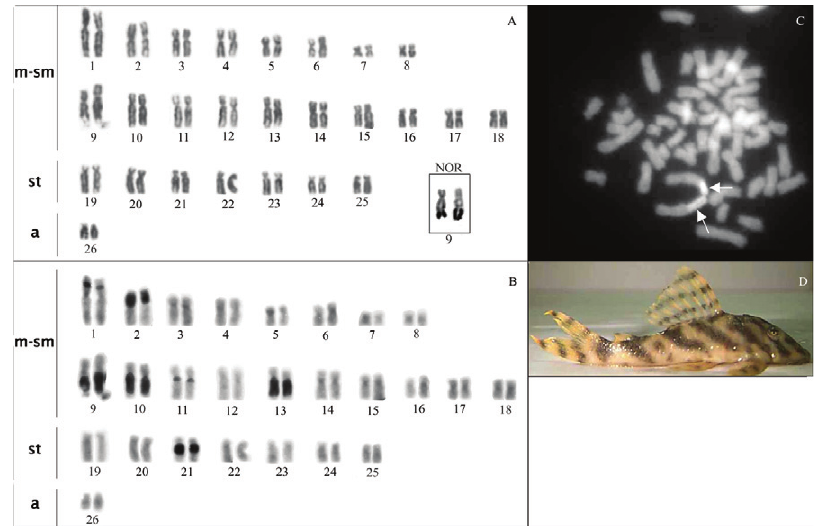
Fig. 1. Karyotype of a Peckoltia vittata , sequentially Giemsa-stained ( A ) and C-banded ( B ) chromosomes. The CMA -stained metaphase of the same specimen ( C ) revealed CMA 3 ated NOR-bearing chromosome pair (arrows). The specimen was obtained from Xingu River ( D